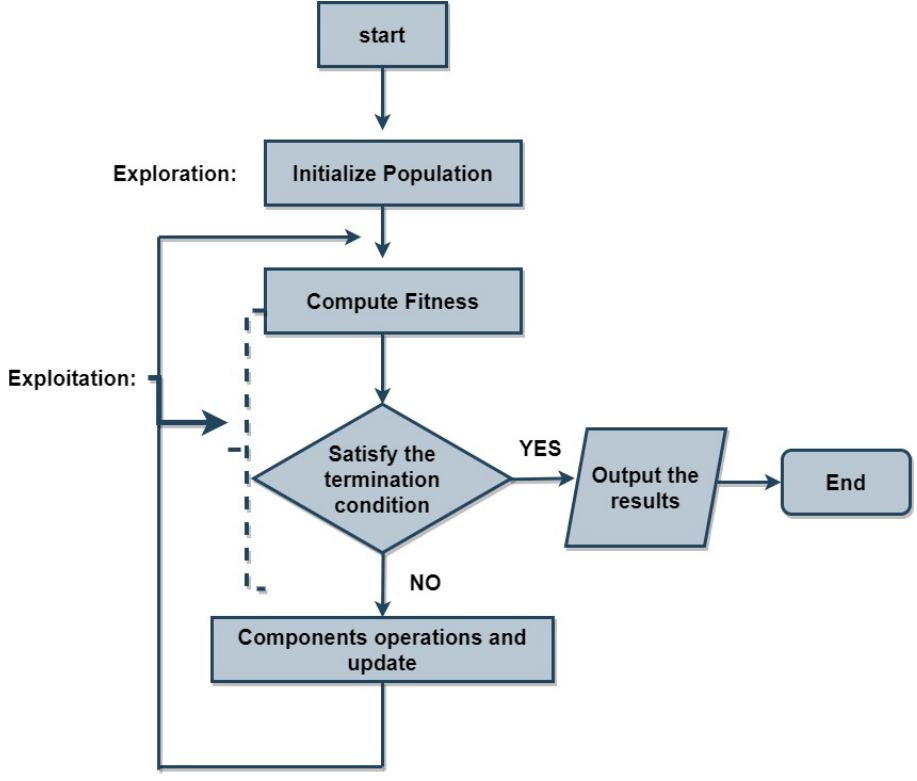
Figure 5. The working procedure of nature-inspired algorithms.